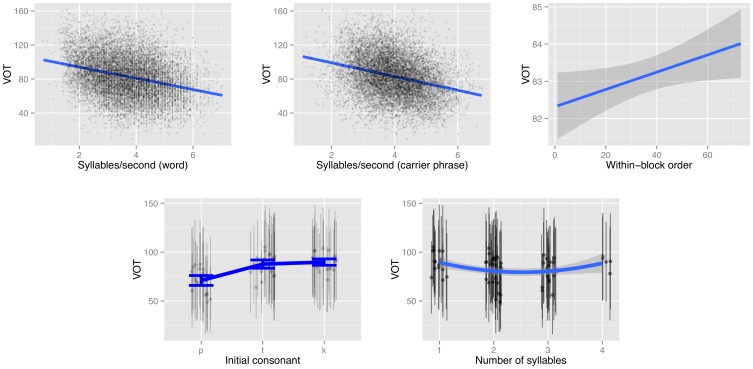
Empirical plots of VOT versus significant predictors in Model 1.For the utterance-level predictors rate1, rate2, and trial (top row), the line and shading show a linear fit and 95% confidence intervals (CIs) to the empirical data, represented by one point per observation (points omitted in the trial plot for legibility). For the word-level predictors consonant (bottom left) and syllables (bottom right), each point and vertical line show the mean and its 95% CI for VOT over all tokens of one word. The error bars for consonant are 95% CIs on the mean of the word-level means; the curve and shading show a quadratic fit to the word-level means and its 95% CIs, corresponding to the coding of syllables (see text).